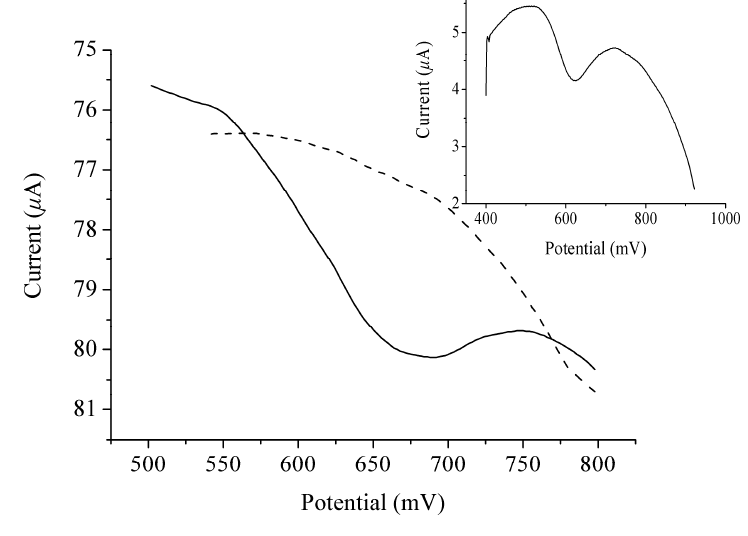
Figure 1. Square wave voltammograms of hIAPP at the concentration of 2.5×10 -5 M (solid line) and 0 M (dashed line). Inset is the square wave voltammogram of tyrosine solution at the concentration of 2×10 -6 M.